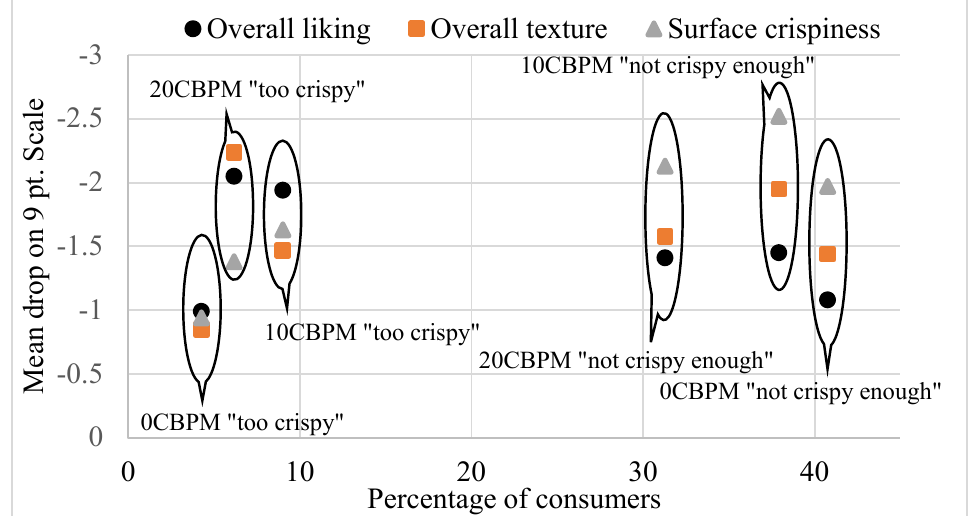
Figure 1. Crispiness penalty plot of fried catfish strips based on a 3-point JAR scale (not crispy enough, JAR, too crispy); 0CBPM, 10CBPM and 20 CBPM = breading mix with 0%, 10% and 20% CBP, respectively.